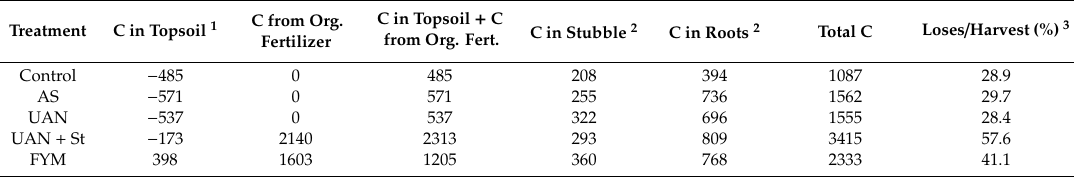
Table 2. C SOM loses due to the mineralization (soil organic matter + fertilizer + crop residues) (in kg C ha − 1 year − 1 ); AS–ammonium sulfate, UAN–urea ammonium nitrate, UAN + st–urea ammonium nitrate + straw, FYM–farmyard manure, C–Carbon.